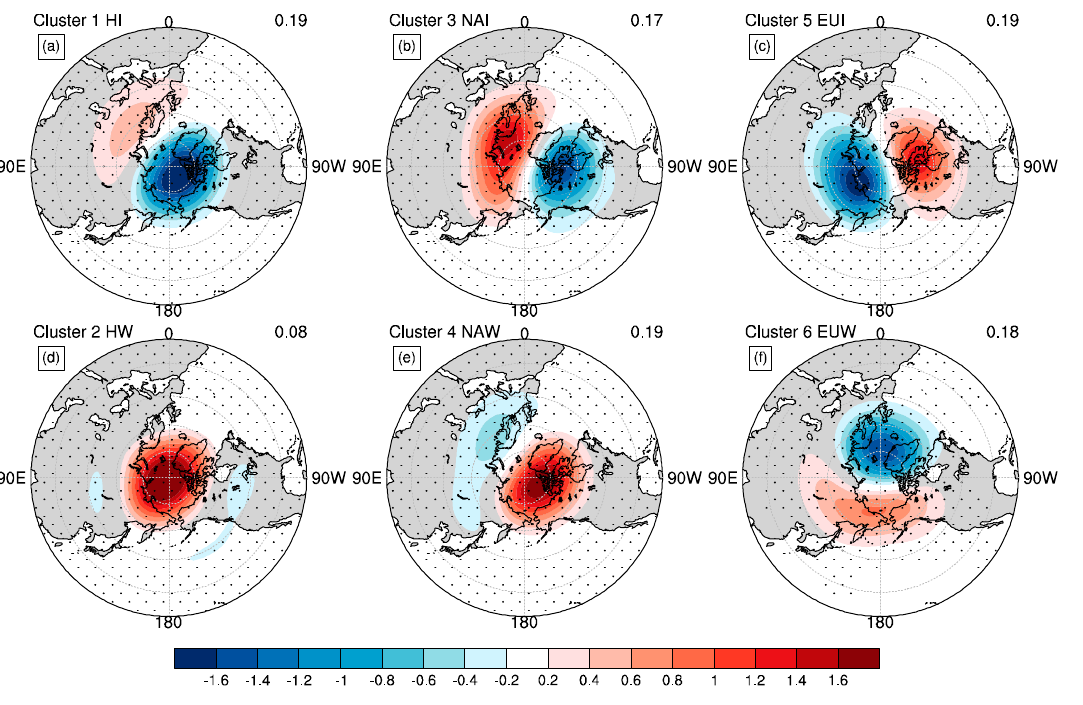
Figure 1. ( a – f ) Composited 50 hPa standardized geopotential height anomalies for the six strato- spheric Arctic vortex weather regimes (shading) over 20–90 ◦ N based on the historical run. The dotted area marks the composite anomalies significant at the 99% confidence level based on a two-sided Student’s t -test. The top right of each plot also shows the frequency proportion for each regime.